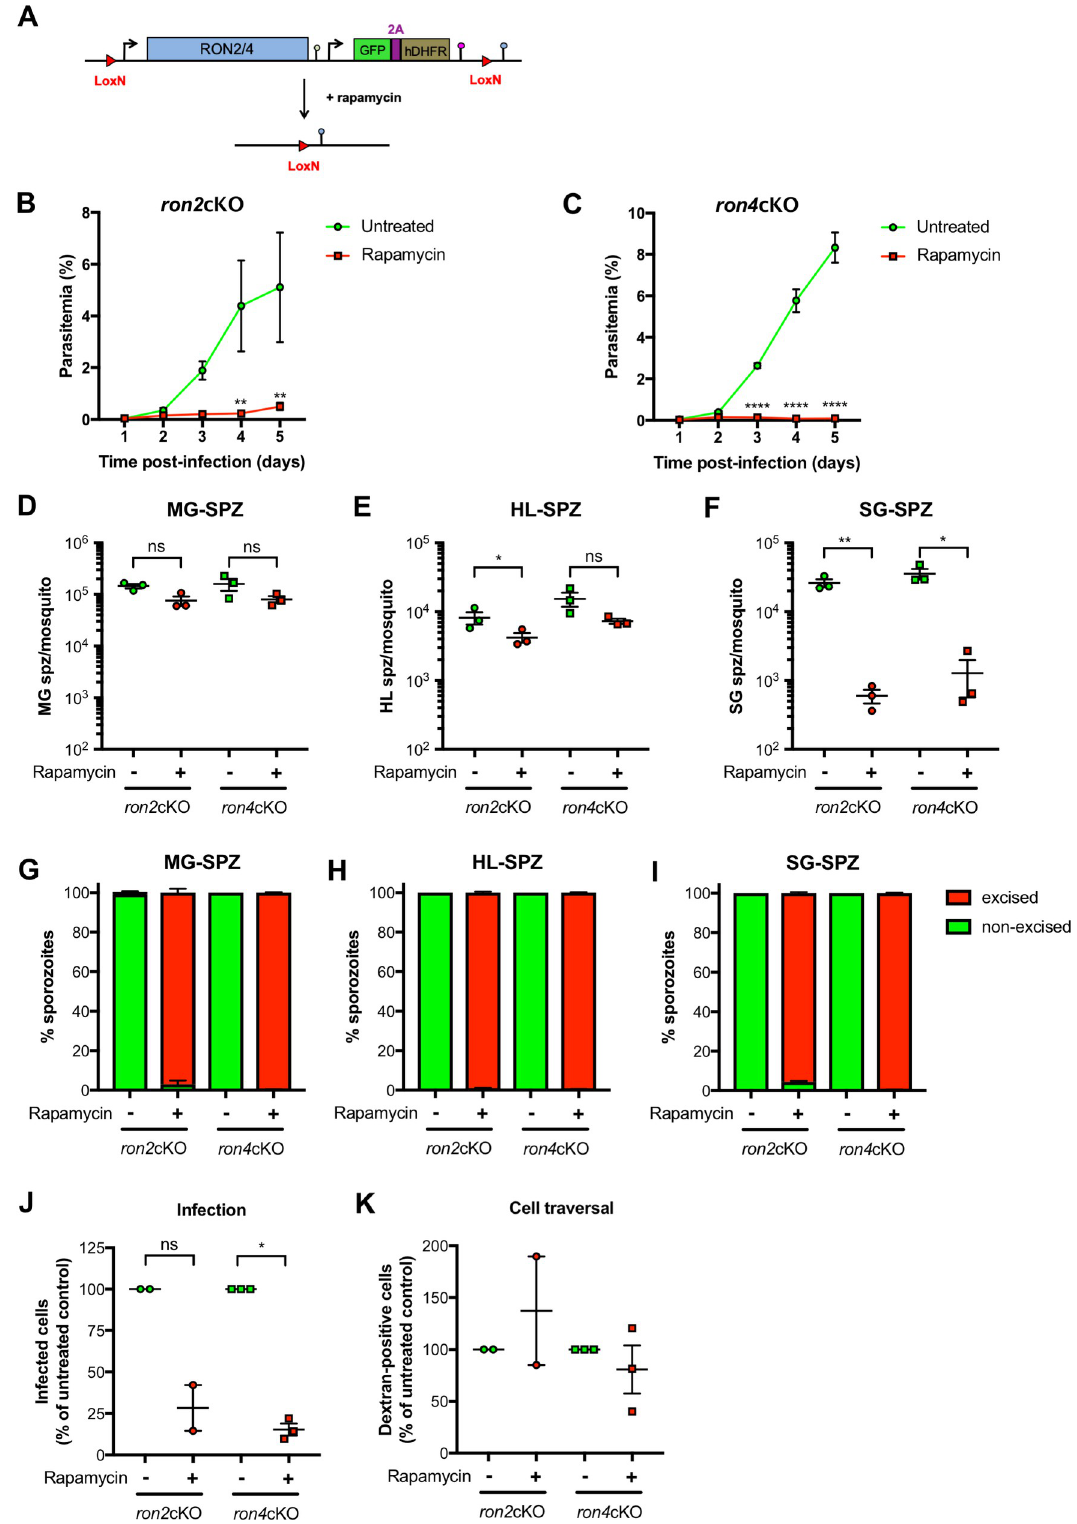
Fig 4. RON2 and RON4 are required for sporozoite invasion in the mosquito and mammalian hosts. A. Strategy to generate ron2 cKO and ron4 cKO parasites in the PbDiCre line. B-C. Blood stage growth of rapamycin-treated and untreated ron2 cKO (B)